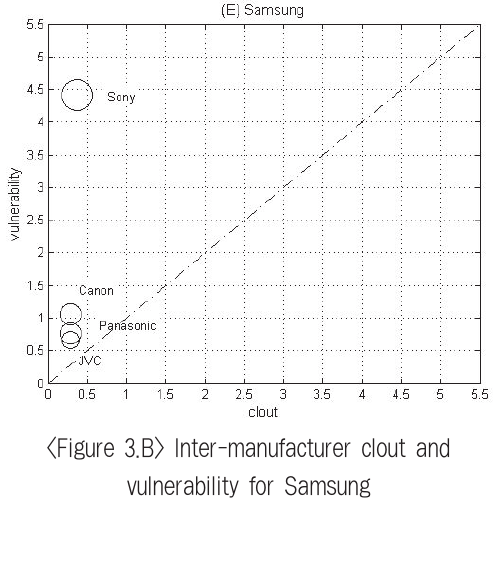
<Figure 3.B> Inter-manufacturer clout and vulnerability